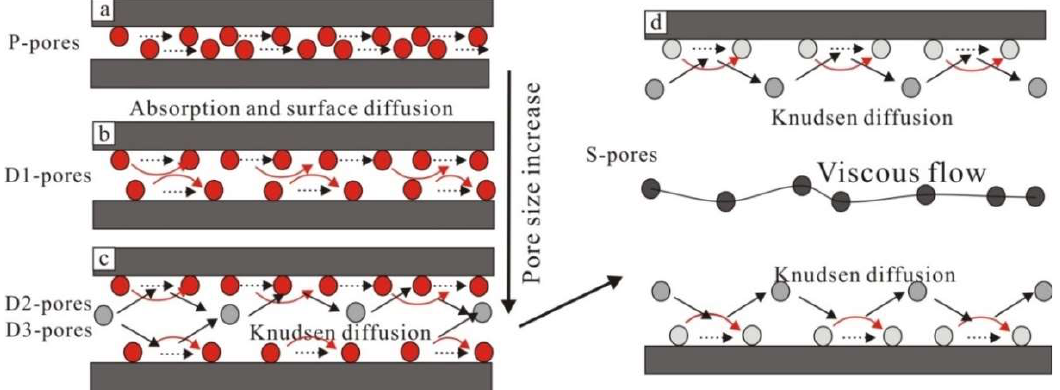
Figure 8. Different transport mechanisms of gas in the (a-d) for P-pores, D1-pores, D2/3-pores, and S-pores.